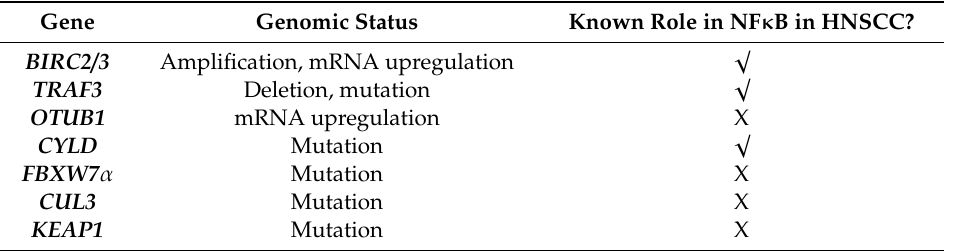
Table 2. Overview of ubiquitin-related genes modulated in HNSCC and have a potential role in NF κ B